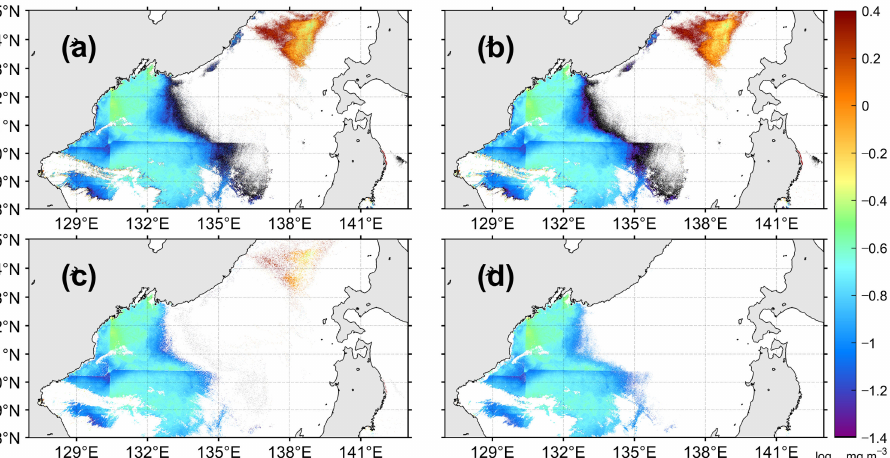
Figure 14. ( a ) Image of level-2 chlorophyll- a concentration image on 13 January 2015, and the result of several speckle removal methods applying a ( b ) 3 × 3 median filter, ( c ) threshold method, and ( d ) the MFNN model in this study applied to ( a